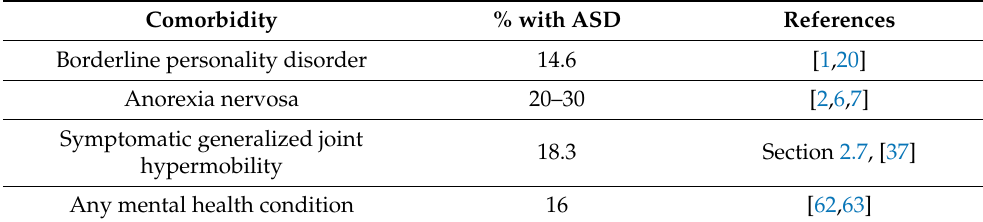
Table 8. Proportion with ASD in comorbid conditions. Comorbidity % with